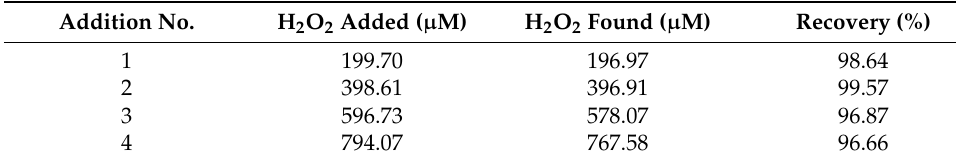
Table 5. Determination of H 2 O 2 in B. subtilis .